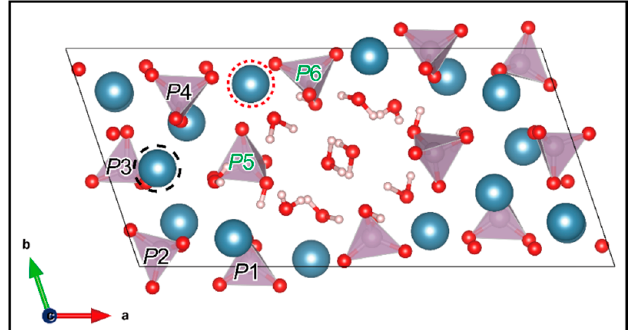
Scheme 1. Schematic illustration of the OCP unit lattice oriented toward the c-axis, with phosphates labeled as P 1 to P 4 in their PO 4 form (black labels) and P 5, P 6 in their HPO 4 form (green labels) drown by VESTA3 program and ref [28,30]. The black dashed circle and red dotted circle indicate Ca ions corresponding to the conjugated sites of P 3 and P 5 PO 4 , respectively.